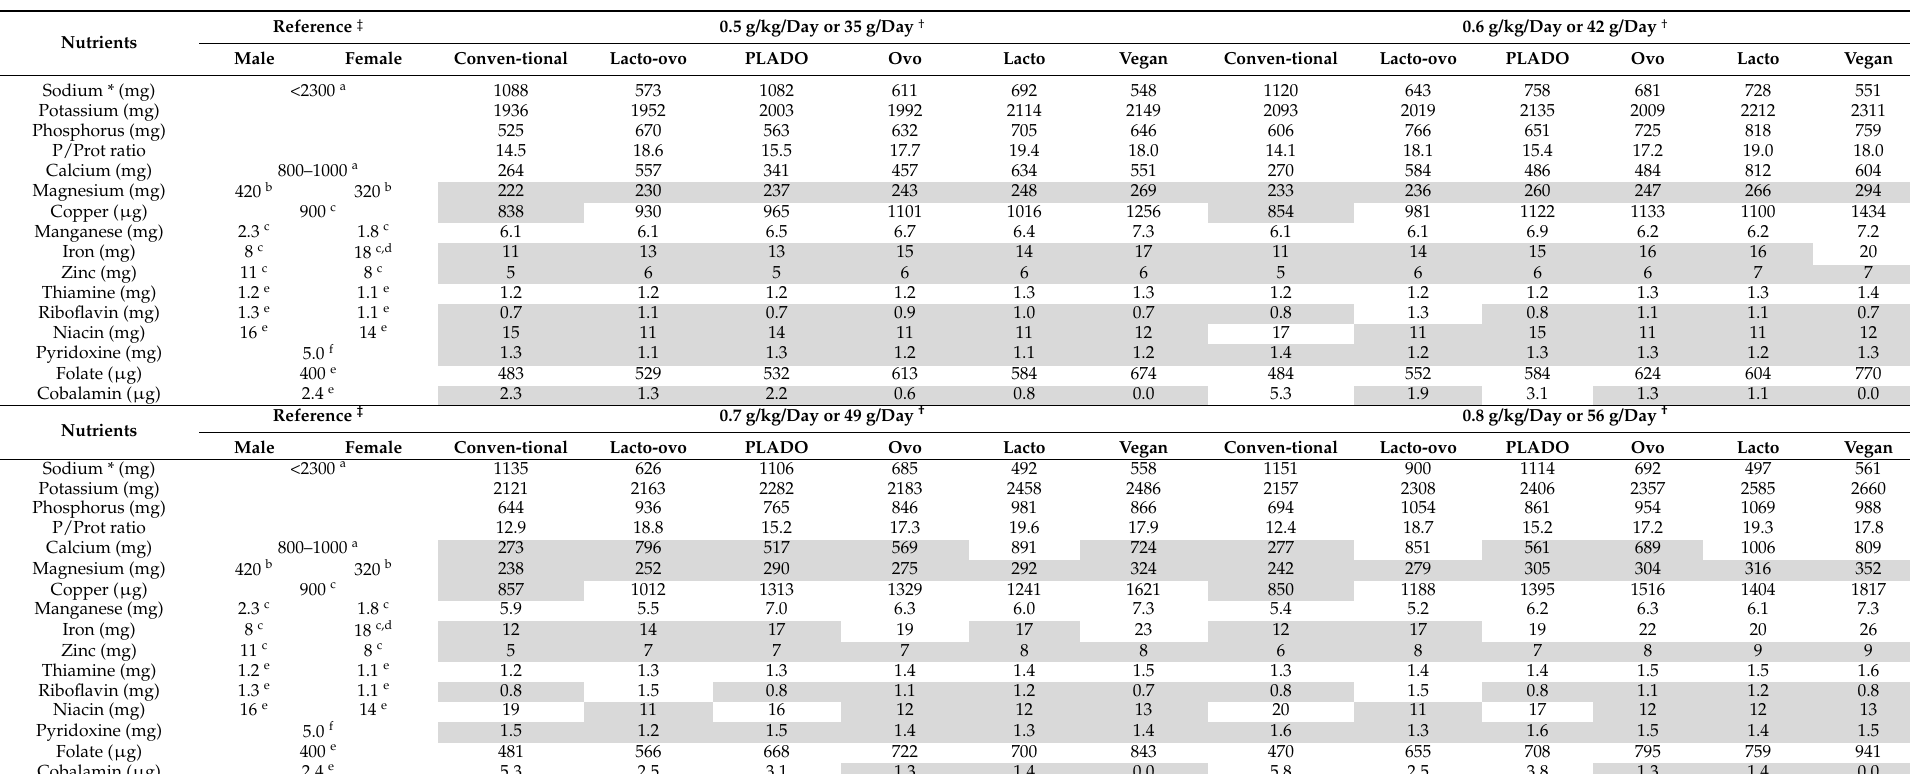
Table 4. Macromineral, trace element, and vitamin content of conventional, plant-based, and vegetarian low protein diets.